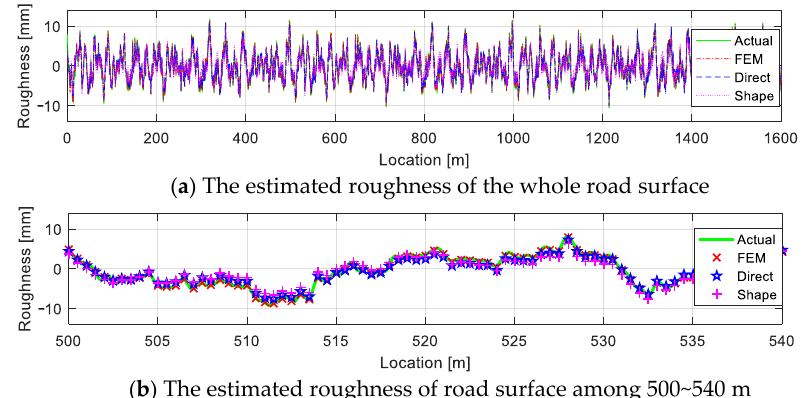
Actuators 2021 , 10 , x FOR PEER REVIEW